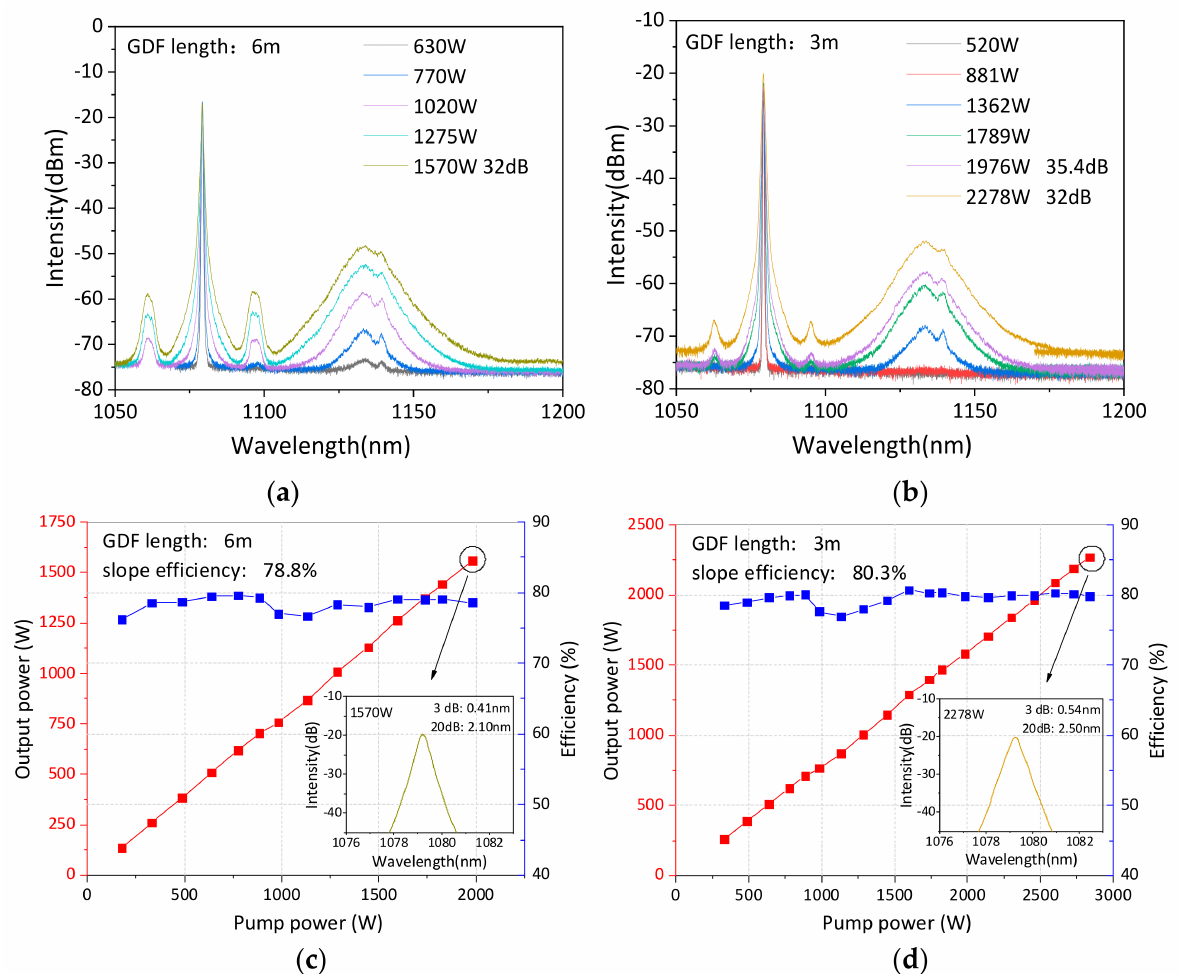
Figure 3. The output spectrum versus output power ( a ) with GDF length of 6 m ( b ) with GDF length of 3 m. The output power and efficiency versus pump power ( c ) with GDF length of 6 m ( d ) with GDF length of 3